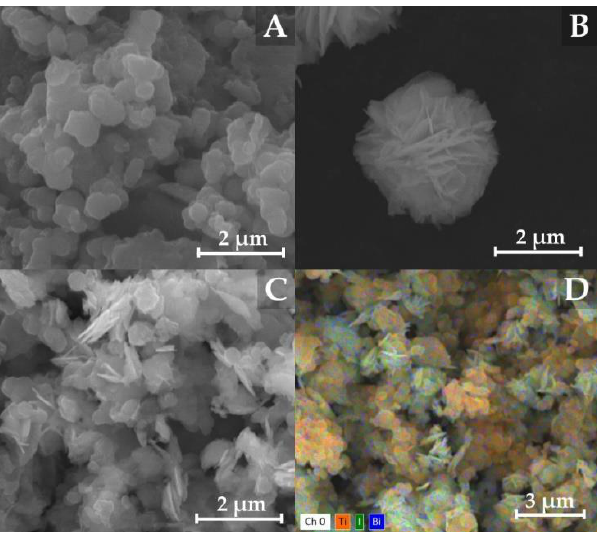
Figure 4. SEM micrographs of ( A ) titanium dioxide; ( B ) bismuth oxyiodide; ( C ) 20% BiOI/TiO 2 ; ( D ) SEM-EDS of 20% BiOI/TiO 2 . Table 1. Structural and electronic properties of the synthesized semiconductor photocatalysts.